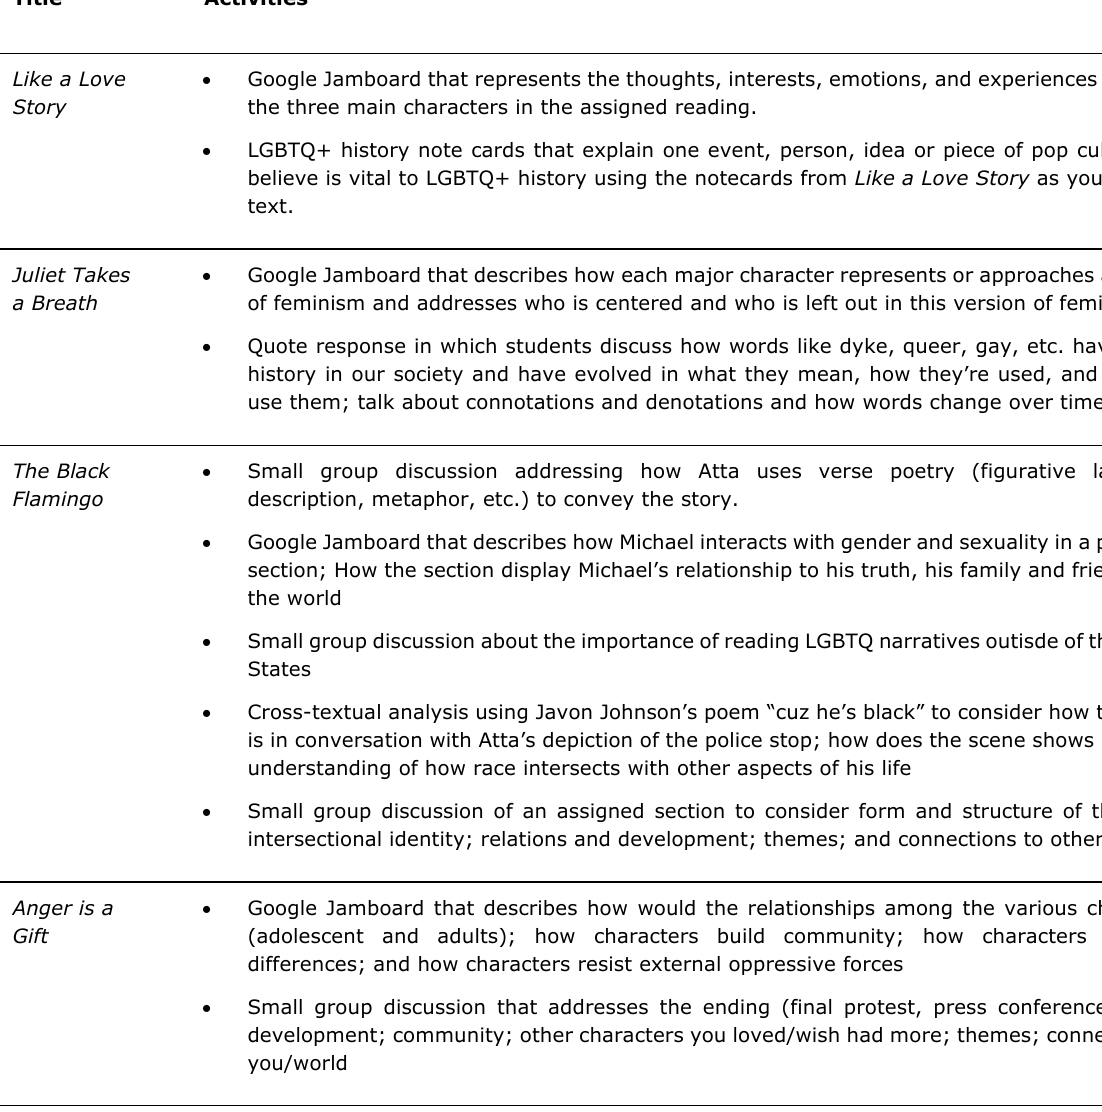
Activities to Support Intersectional and Anti-Oppressive